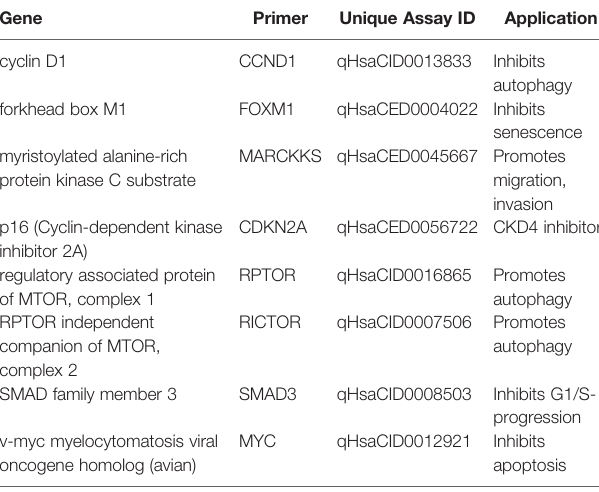
TABLE 1 | Primer for target genes.